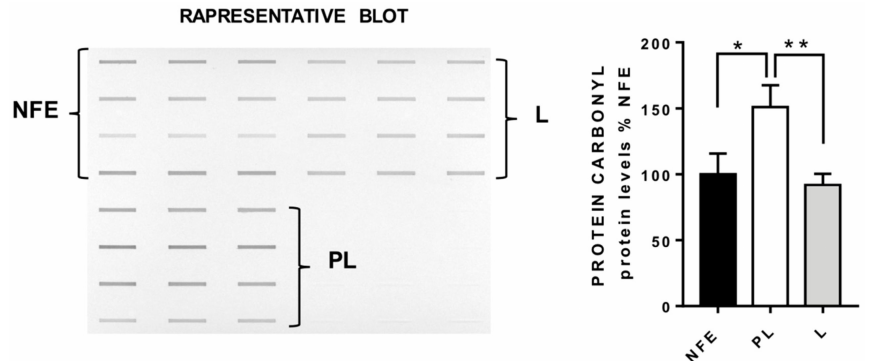
Figure 3. Slot blot analysis of total protein carbonylation. Panel A (left hand side): Slot blot of a representative sample from non-photo exposed (NPE), perilesional (PL) and lesional (L) groups. A triplicate of 4 samples per group is showed. Panel B (right hand side): Densitometric analysis of total protein carbonylation in NPE, PL and L groups. NPE is set as 100%. The bars show the averages of 7 samples per group ± standard error of the mean (SEM); * p < 0.05, ** p <